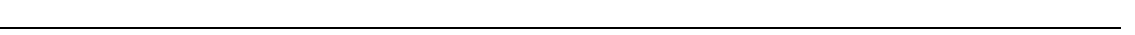
Fig. 5 Function of the OLPs in phototaxis. a Schematic representation shows the connectome of the larval visual system. Rh5-PRs form chemical synapsis with different projection neurons. Rh6-PRs predominately make synaptic contact with the two lOLPs and the Pdf-LNs. The lOLPs form chemical synapsis with direct target cells of Rh5-PRs (adapted from ref. 28 ). b OLPs are not necessary to steer away from light. + /shi TS : n = 10, p = 3.9 × 10 − 5 ; pOLP > shi TS : n = 10, p = 0.0043; pOLP / + : n = 10, p = 0.0138; allOLP > shi TS : n = 10, p = 1.0 × 10 − 6 ; allOLP / + : n = 10, p = 7.5 × 10 − 8 . Mean steering of experimental